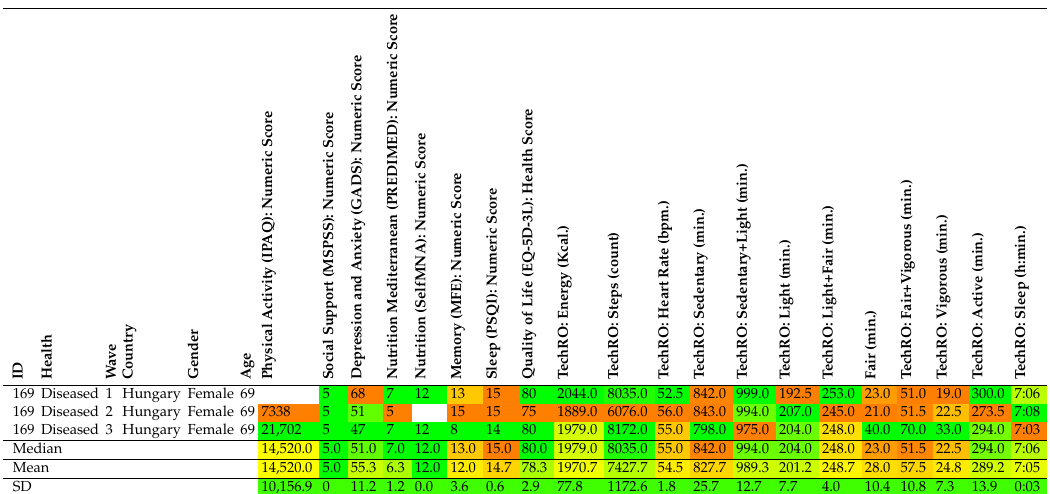
Table 17. Summary of Characteristics of PRO (IPAQ, MSPSS, GADS, PREDIMED, SelfMNA, MFE, PSQI, EQ-5D-3L) and median TechRO (Fitbit) over the measurement period corresponding to each wave for Participant 169.